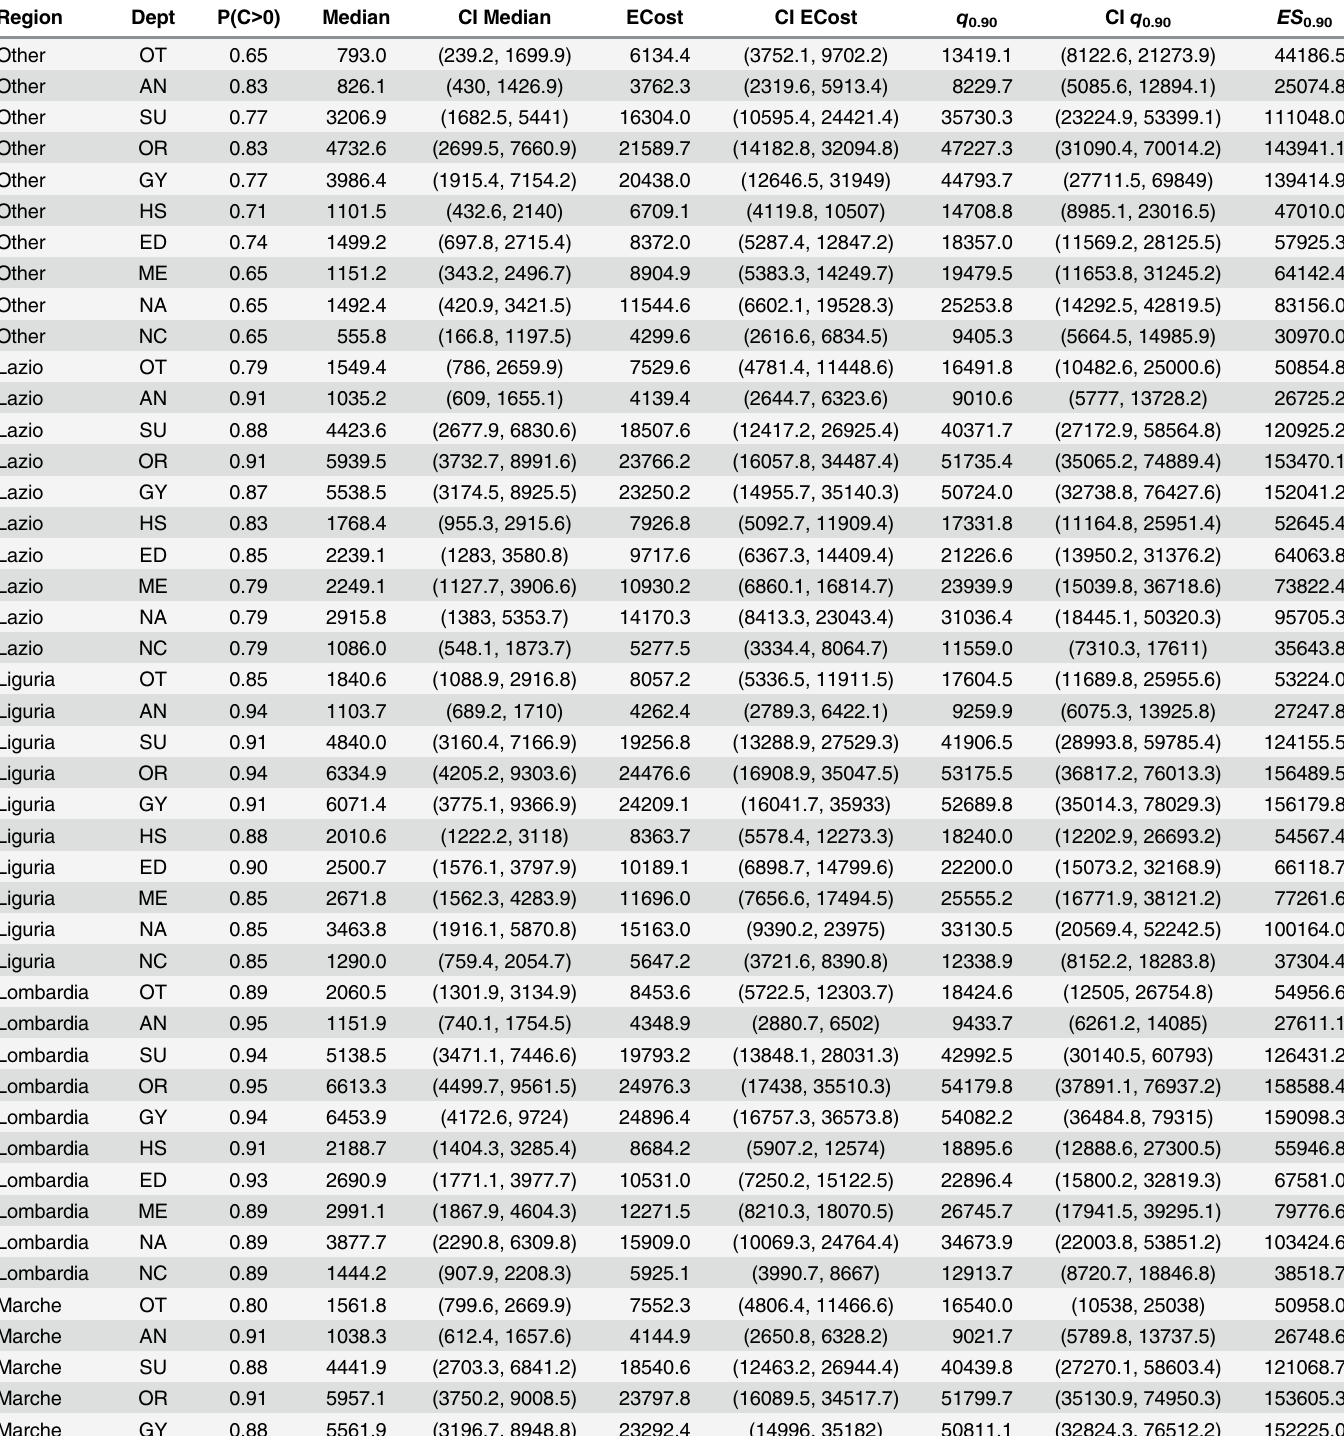
Table 16. Forecast probability of non-zero amounts, median amounts (with 95% confidence interval), expected amounts (with 95% confidence interval), 90th quantiles (with 95% confidence interval), and conditional 10%-tail expected amount (shortfall), by region x department as identified by the models. Forecasts refer to 30 June